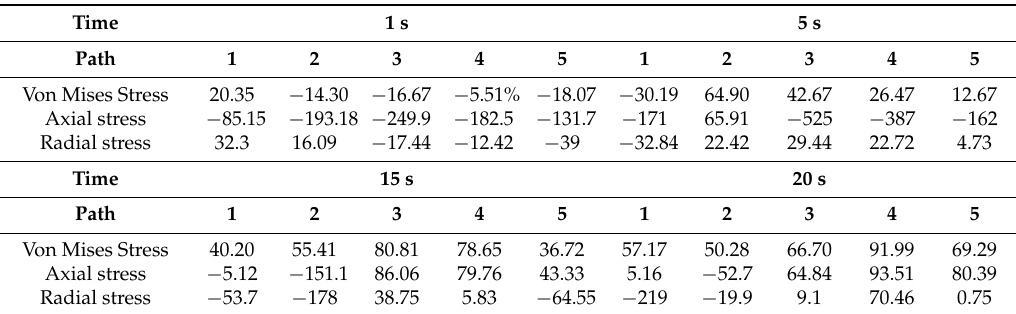
Table 6. Comparison of stress release effect (%). The positive value means release of the stress and the negative value means aggravation of the